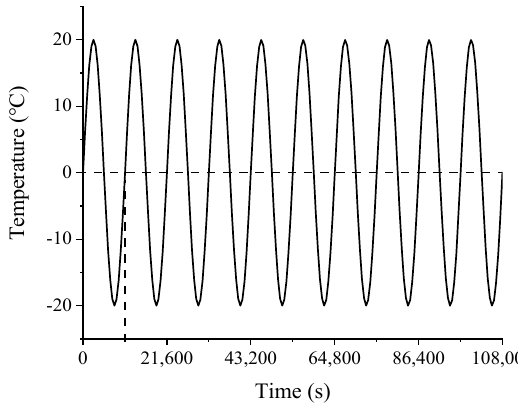
Figure 12. Temperature variation of 10 freeze–thaw cycles.